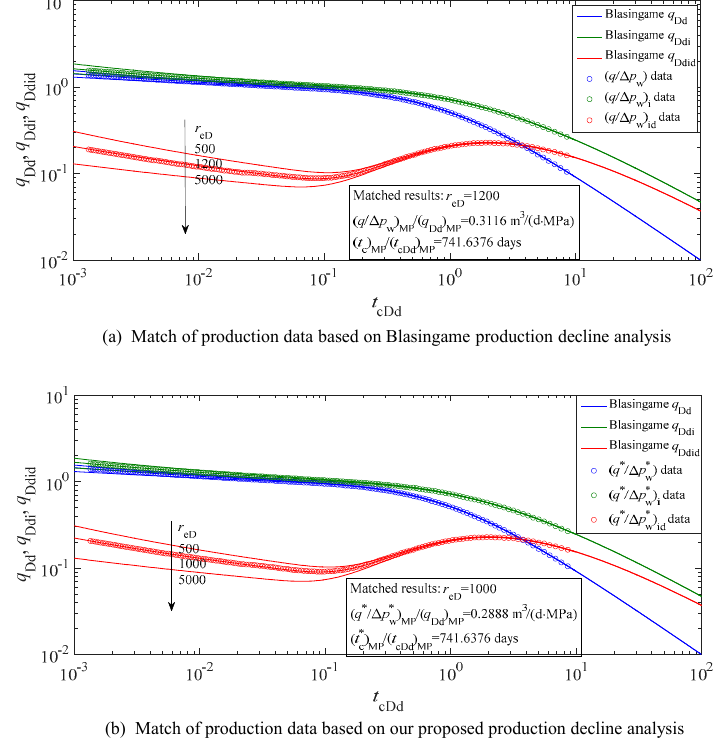
Figure 24. Match of production data for Case 1.